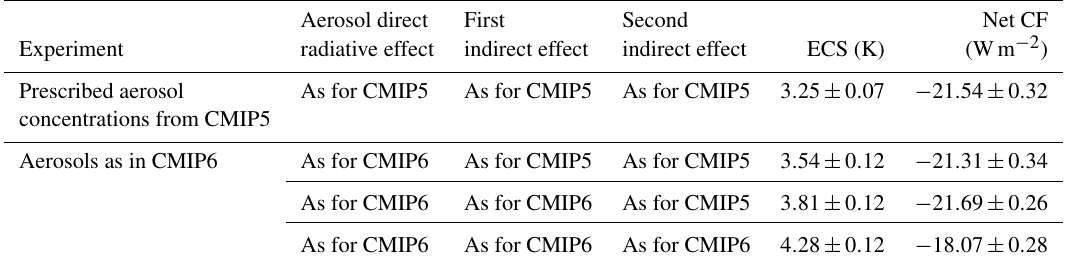
Table 4. Sensitivity of ECS and net CF to different realisations of the aerosol–cloud interaction processes. All experiments were carried out with the low-resolution (T159L62) configuration of EC-Earth3-Veg and stretch over only 75